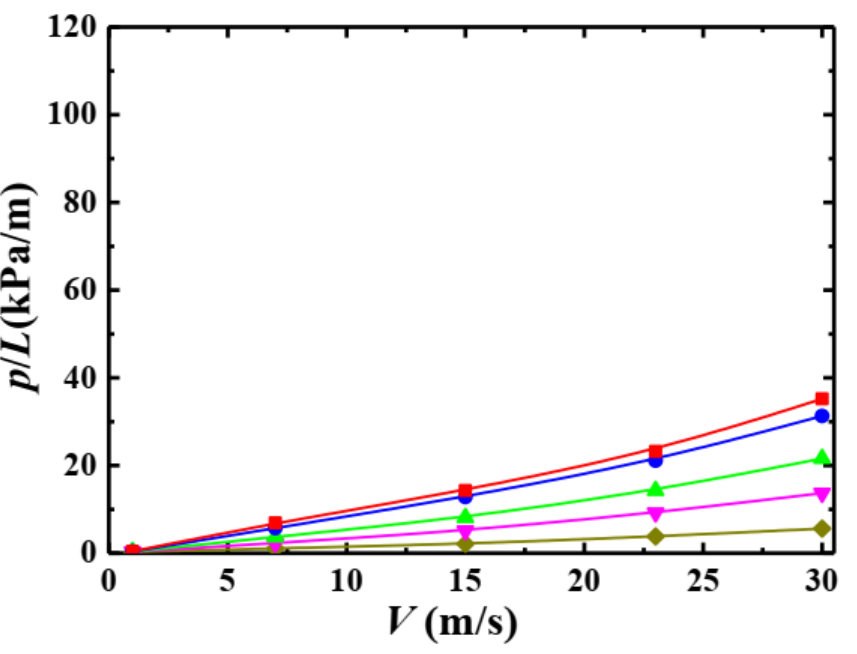
Figure 12. Relationship between p / L and V for different particle diameters ( α s = 5%, m s = 15 t/h). d p : (cid:4) : 50 µ m; • : 100 µ m; (cid:78) : 500 µ m; (cid:72) : 750 µ m; (cid:7) : 1000 µ